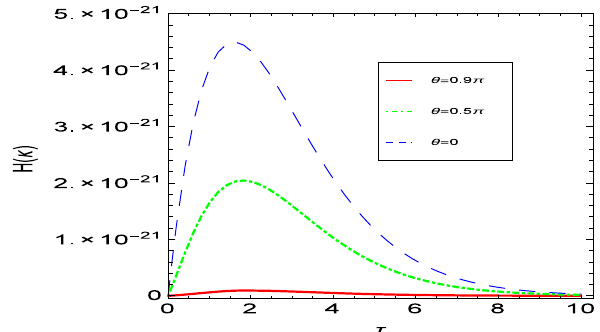
Fig. 1 QFIintheestimationofthedeformationparameterasafunction of the effective time τ with fixed values of θ . The effective deformation parameter is fixed as κ = 1000 and the velocity of detector is given by v = 0. The different initial state parameter θ = 0 , 0 . 5 π, 0 . 9 π ,